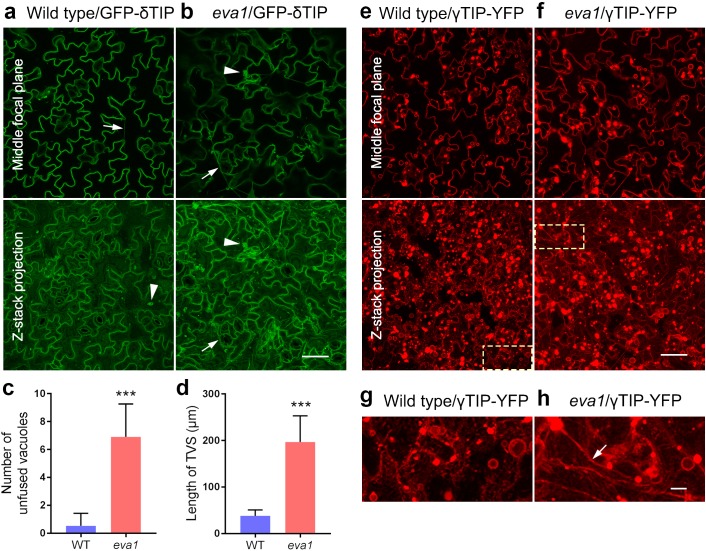
eva1 mutants show vacuolar phenotypes of TVSs and presumably unfused vacuoles.(a and b), Confocal images of cotyledon epidermal cells expressing GFP-δTIP in 10 day old wild type and eva1 plants. Arrows point to TVSs and arrowheads indicate small vacuoles, which are rarely seen in wild type but prominent in eva1. Scale bar for (a and b), 50 μm. (c and d), Quantification of eva1 vacuolar phenotypes. (c) Number of presumably unfused vacuoles. n = 40 cells for each genotype. (d) Length of TVSs. Notably, in 10 day old wild-type cotyledon epidermal cells, TVSs are rarely observed. Cells of eva1 background have numerous TVSs, and only the longest string in each cell was measured. n = 16. Values are mean ± SD. The asterisks indicate significant differences compared to wild type (***p≤0.001, unpaired t test). (e – h) Confocal images of cotyledon epidermal cells expressing γTIP-YFP in 10 day old wild type and eva1 plants. Dash-line yellow boxes in e and f) indicate regions of interest, which are magnified in (g and h). The arrow indicates enhanced TVSs. Scale bar for (e and f), 50 μm. Scale bar for (g and h), 10 μm.